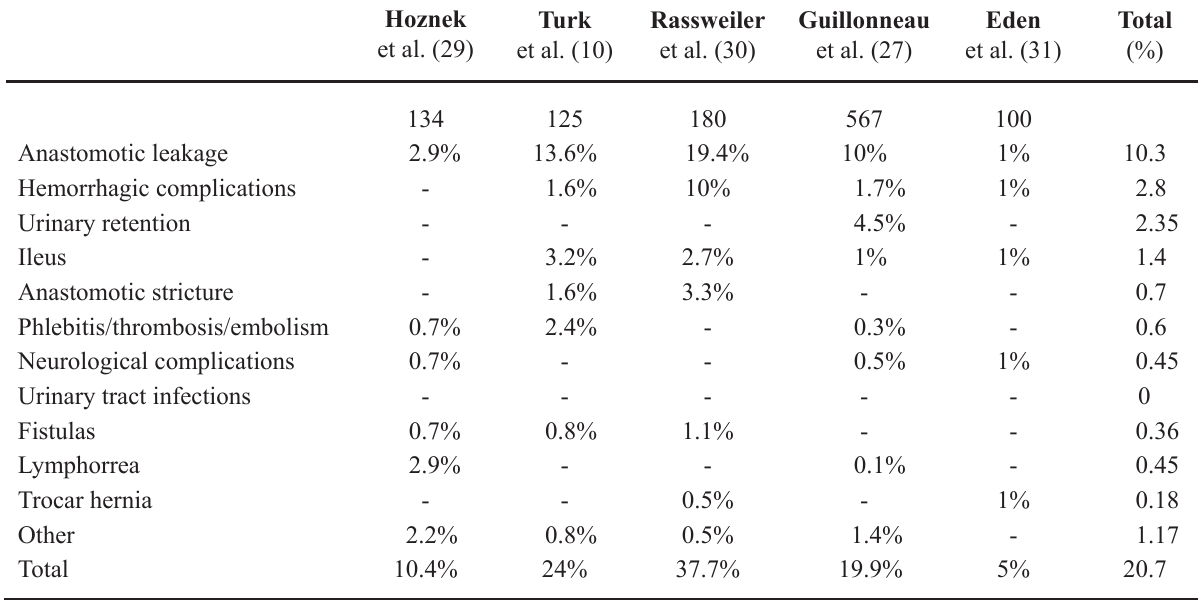
Table 4 – Early postoperative complications in early series with more than 100 patients.